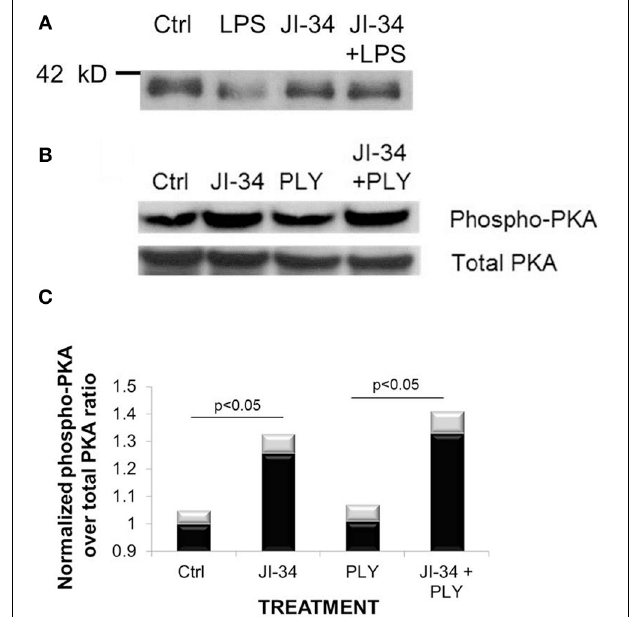
FIGURE 6 | Representative Western blots of the PKA-activating activity of a 30min JI-34 preincubation (1 μ M) in ctrl, LPS (2h, 200ng/ml)- or PLY-(30min, 30ng/m) treated HL-MVEC. (A) Expression of PKA protein substrates in LPS-treated or control cells, in the presence or absence of JI-34; (B) Phospho-PKA and total PKA protein expression in control and PLY-treated cells, in the presence or absence of JI-34. (C) Quantification of phospho-PKA over total PKA ratio ( n = 3 per group, mean ± SD